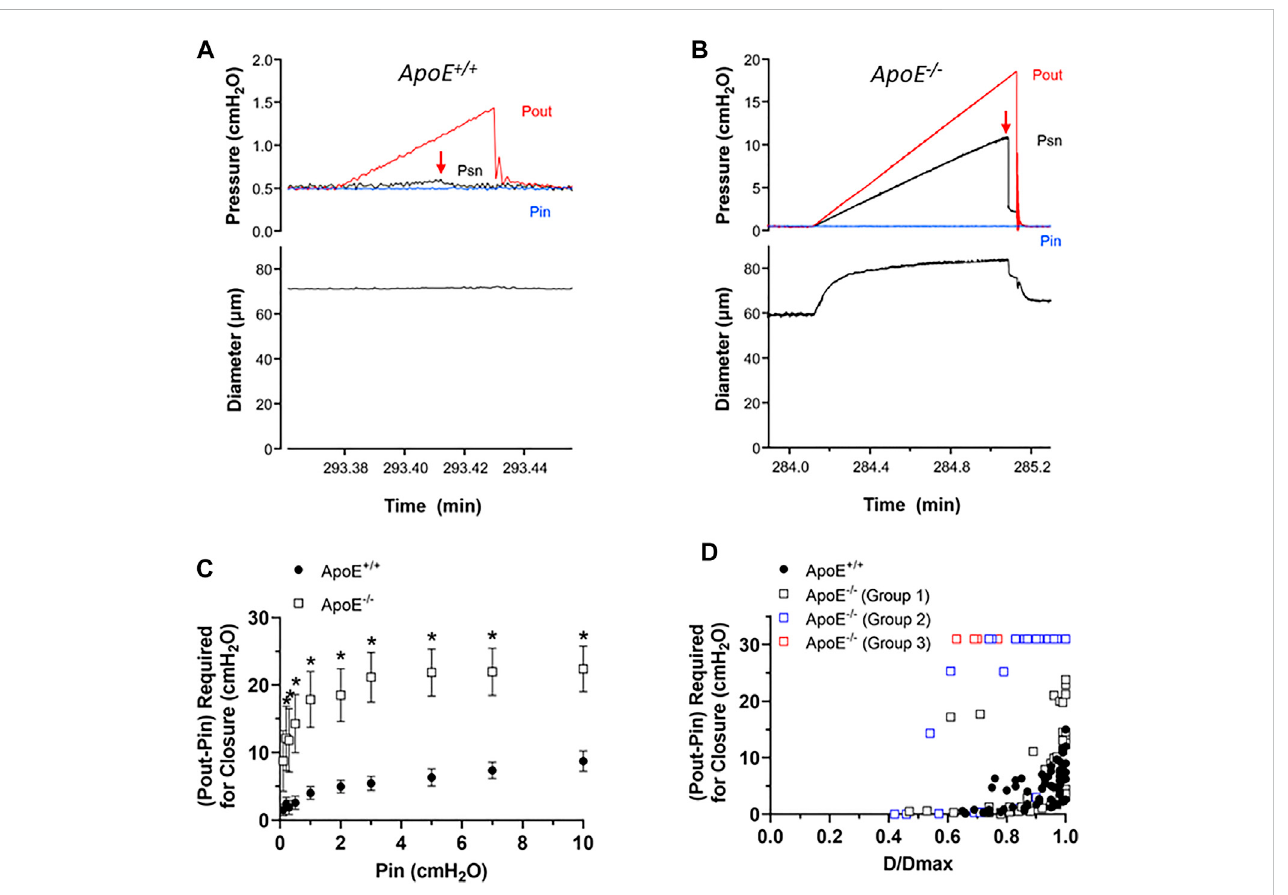
FIGURE 3 ApoE − / − valvesrequireahigheradversepressuregradientforclosure. (A – B) Examplesofvalveclosuretestsforisolated ApoE +/+ (A) and ApoE − / − (B) valves. Note the difference in the y -axis scales between the two panels. (C) Summary data showing that normal valves require a slightly higher adverse (Pout-Pin) pressure gradient ( Δ P) to close avalve as baseline pressure(Pin) rises. (D) When Δ Pfor closureisplottedas afunction ofnormalizeddiameter,therelationship iscurvilinear.Agradientof.1 cmH 2 Oissuf fi cienttocloseatypicalvalveatlowdiameter(~.6 D/Dmax),whereasahigherpressuregradient(2 – 15 cmH 2 O) isneedednearmaximaldiameter.7of7 ApoE +/+ valvesclosedwithinthenormalrangeofadversepressuregradients.Incontrast,5of11 ApoE − / − valvesshowed normal closure curves, 4 of 11 closed at low diameters but would not close at higher diameters, and 2 of 11 ApoE − / − valves would not close at any adverse pressure gradient tested. Statistical differences were assessed via mixed-effects model ANOVAs with Geisser-Greenhouse correction with Sidak ’ s multiple comparisons